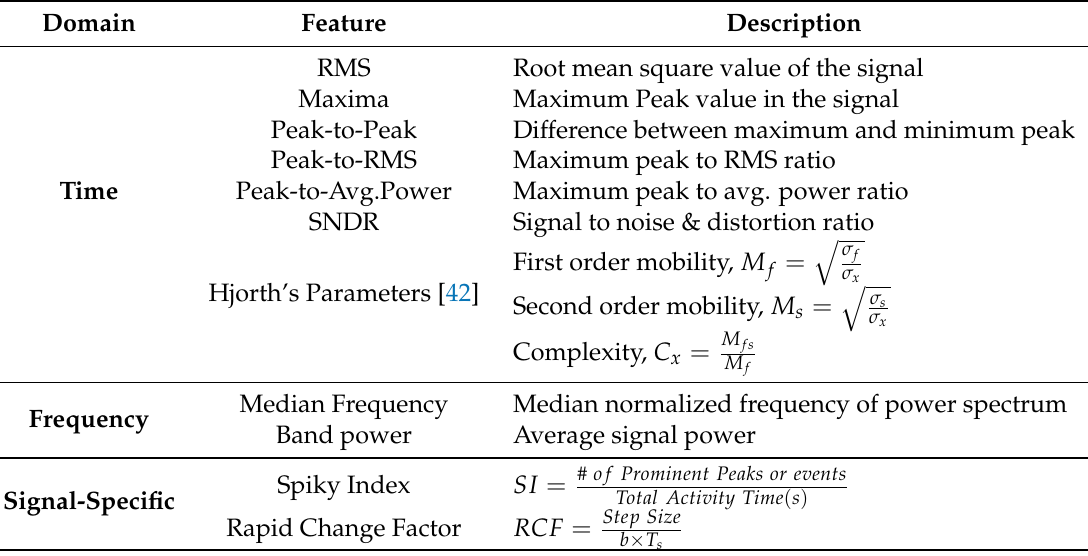
Table 3. Features and their